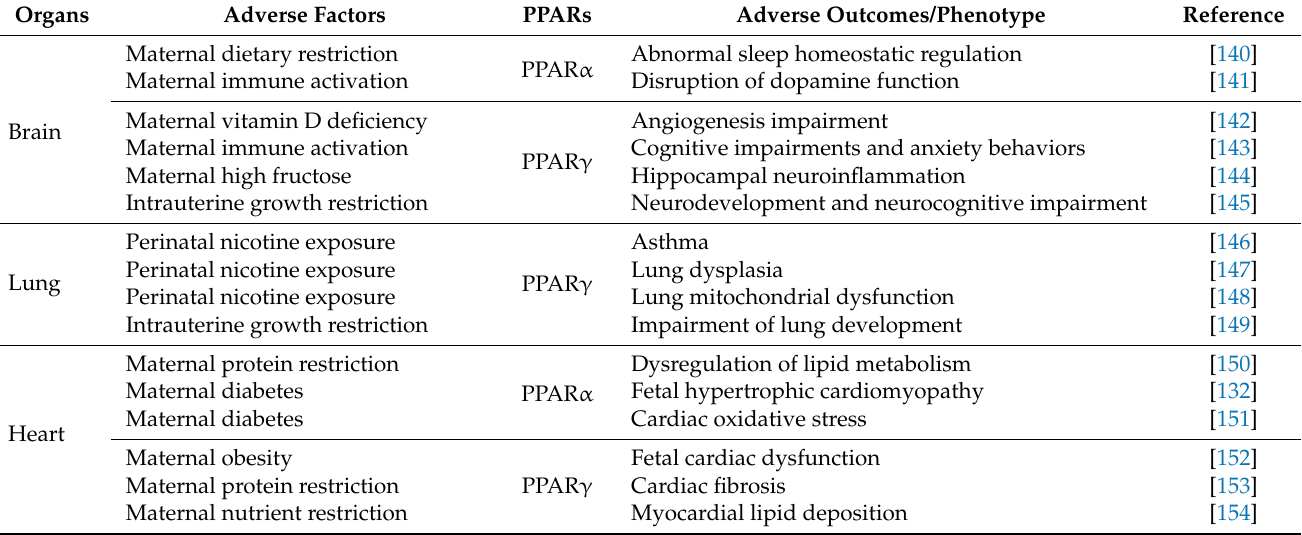
Table 1. Summary of studies on PPARs in the fetal origins of adult